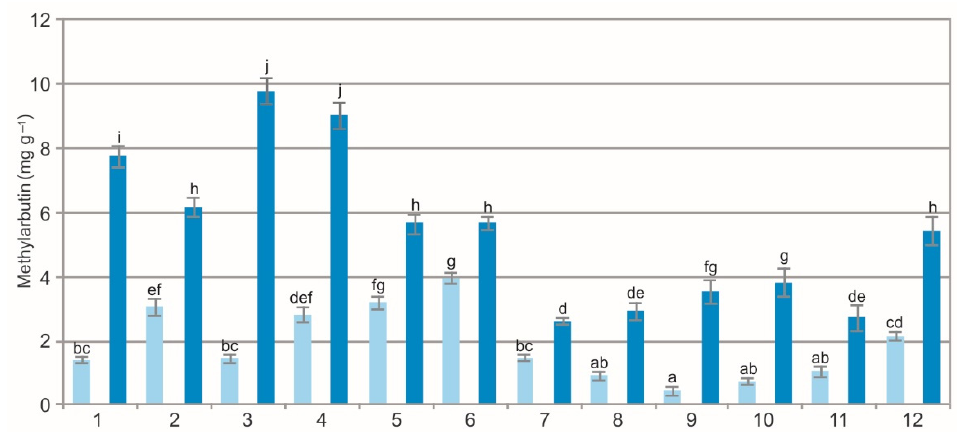
Figure 5. Methylarbutin concentration in water (light blue) and ethanol (dark blue) leaf extracts from bearberry plants in different populations. The values designated by the different letters are significantly different ( p < 0.05).